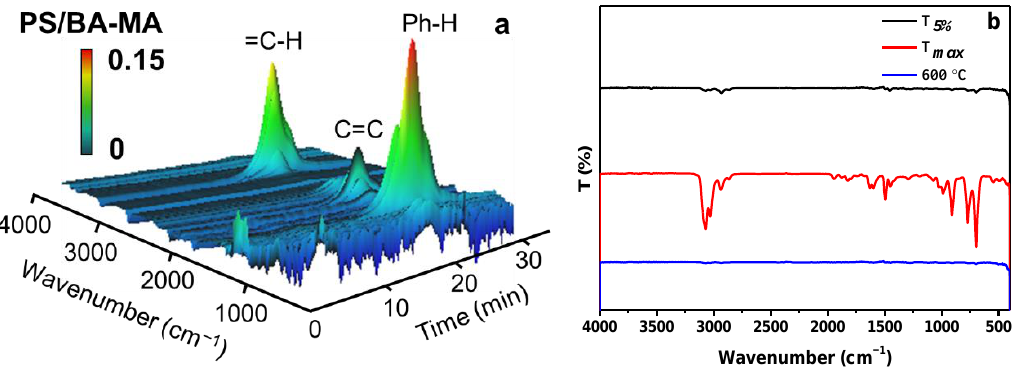
Figure 12. FTIR 3D map of evolved products at various times ( a ) and typical FTIR spectra at different